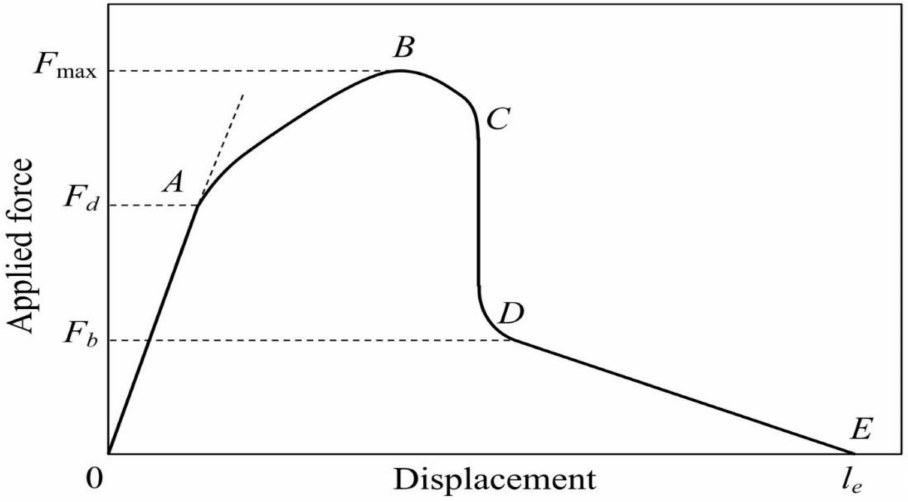
Figure 1. An idealized force–displacement curve in the pull-out test (for details, see